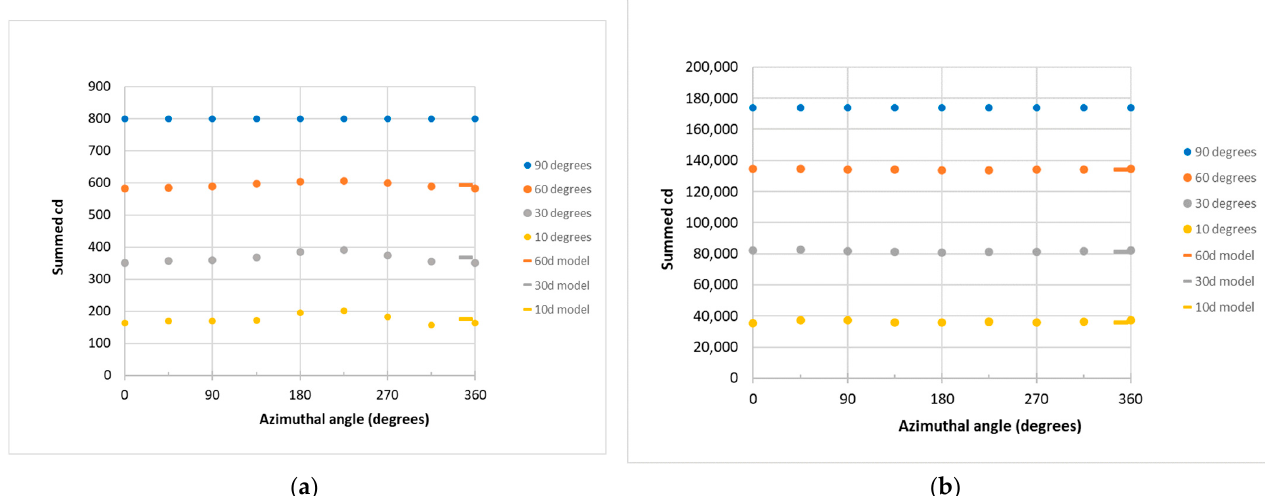
Figure 4. ( a ) The calculated diffuse emission for Ballindangan for a range of azimuth and altitude angles and ( b ) the data for the test area of Dublin. Each row of dots represents a different altitude/zenith distance. The short line at the righthand side of each row represents a scaled version of the observed emission towards zenith under the assumption that the emission is simply a Lambertian scaling of the zenithal emission. Note that the variation in the azimuthal direction is relatively small in this case and that the emission is reasonably close to Lambertian in nature, though the emission to the zenith is approximately 70% of the unobscured value for Ballindangan and 58% for Dublin.